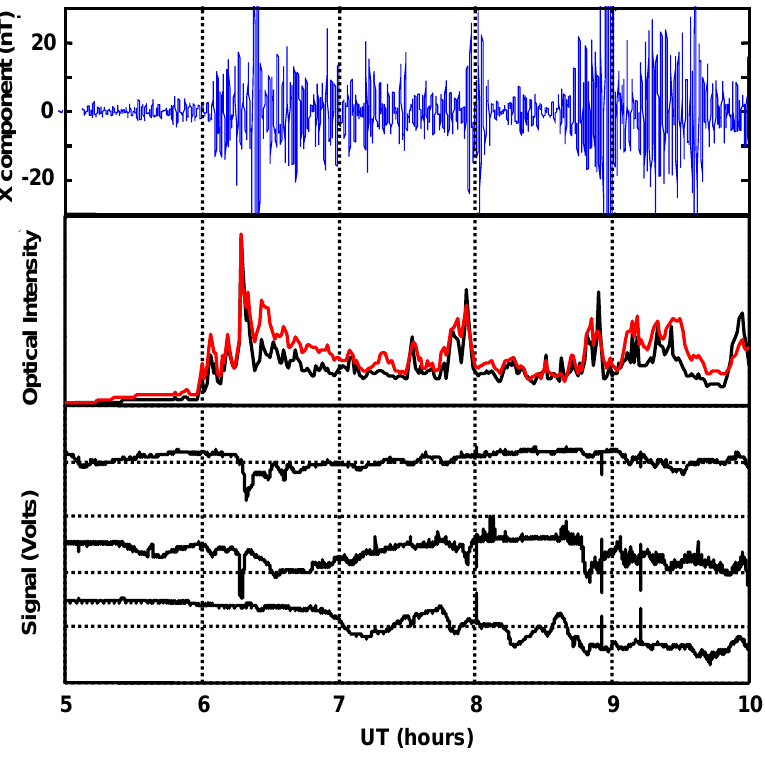
Fig. 8. CANOPUS nightside obser- vations illustrating elevated geomag- netic and auroral activity. The Pi2 filtered magnetic signature at Gillam is shown (top) with latitude-integrated (red) and peak (black) optical inten- sity at 557.7nm from a co-located MSP (middle). The bottom panel is a stack plot of riometers from the Churchill line; Churchill, Gillam and Island Lake from top to